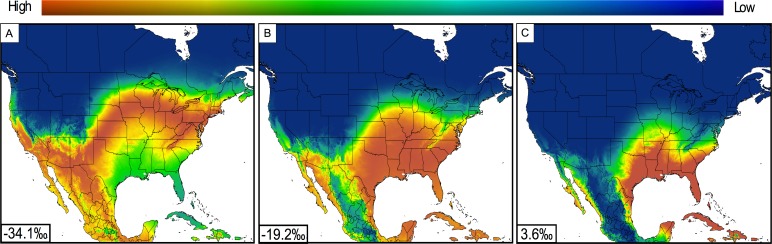
Likelihood-of-origin maps for a δ2Hhair value of −40‰ that was transformed into δ2HGSprecip for L. borealis and L. cinereus.The likelihood-of-origin maps (A, L. borealis and B and C, L. cinereus) were created using the geostatistical tool IsoMAP. Inset values represent the δ2HGSprecip values after transformation (using the combined relationship in Fig. 3A of this study for L. borealis (A), Cryan et al., 2004 (B) and Cryan, Stricker & Wunder, 2014, (C) L. cinereus).